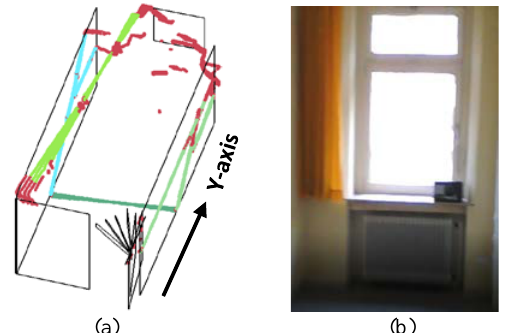
Figure 3. An example of a problematic area for the LiDAR- based SLAM. a) 3D reconstructed planes (black) with the assigned laser points from four scans (colours indicate point associations to a particular plane) and the points that are not associated to a plane (red). The arrow refers to the Y-axis direction in the model system. b) The wall is in front of the